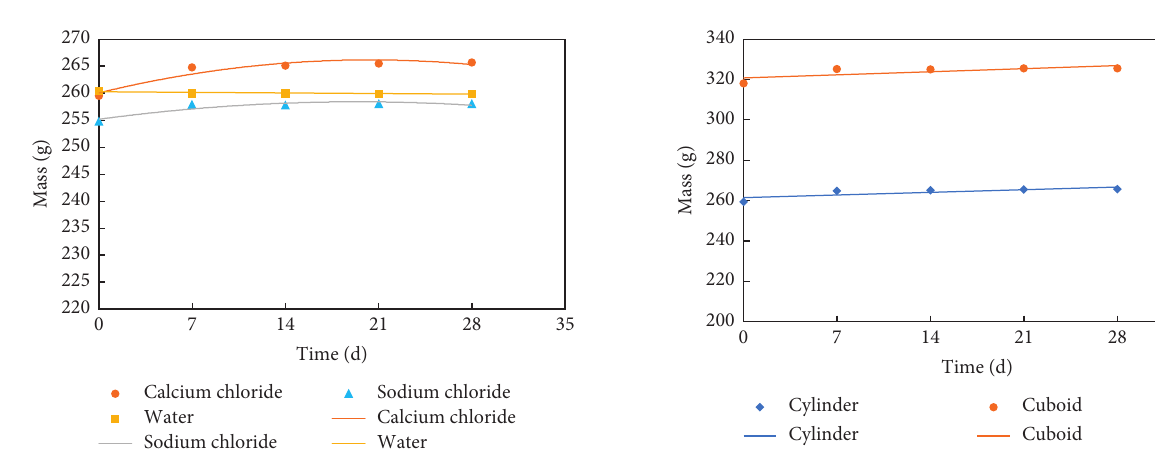
Figure 9: Mass change of the cylindrical specimen of HWC materials in different solutions.